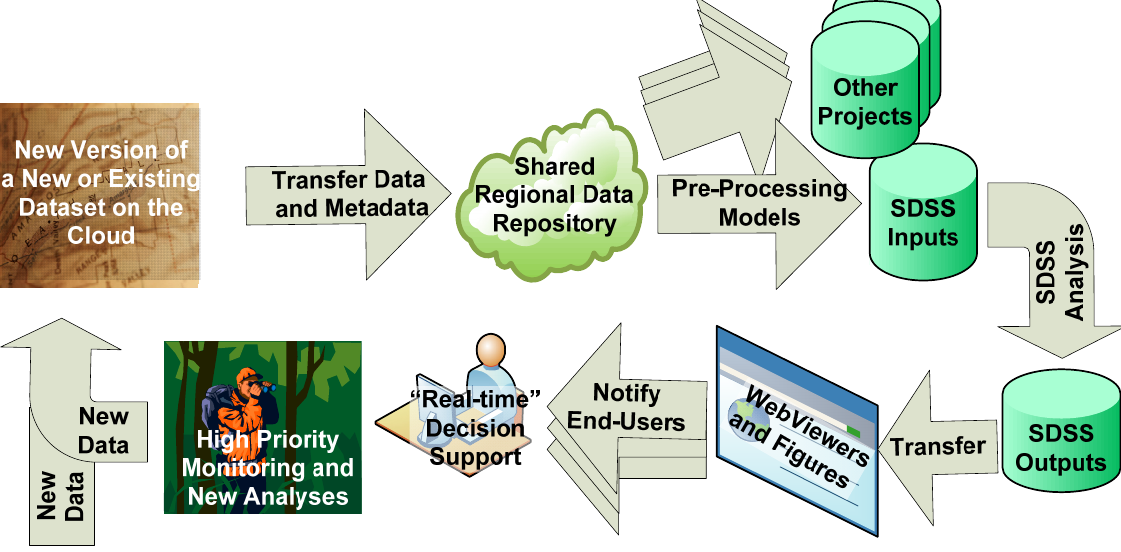
Figure 3. Simplified workflow of a “living” SDSS (spatial decision support system), which is able to provide updated products as conditions change. A challenge in a “living” SDSS is to automate, as much as practical, all the steps within each arrow, and eventually, the linking of all the arrows.